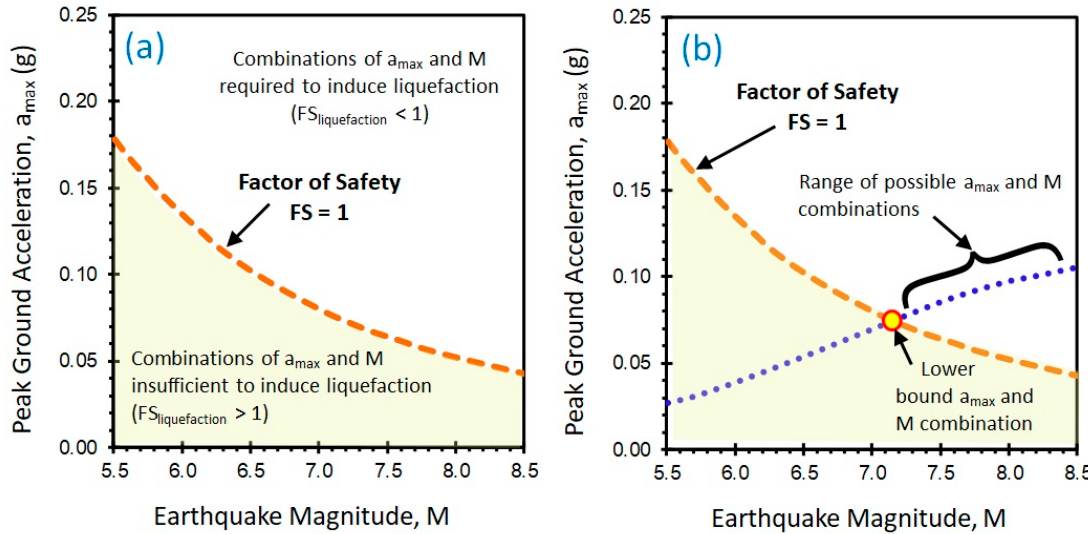
Figure 21. ( a ) a max — M combination required to induce liquefaction at a hypothetical site; ( b ) lower bound a max — M combination determined for the same hypothetical site (modified from Reference [75]).